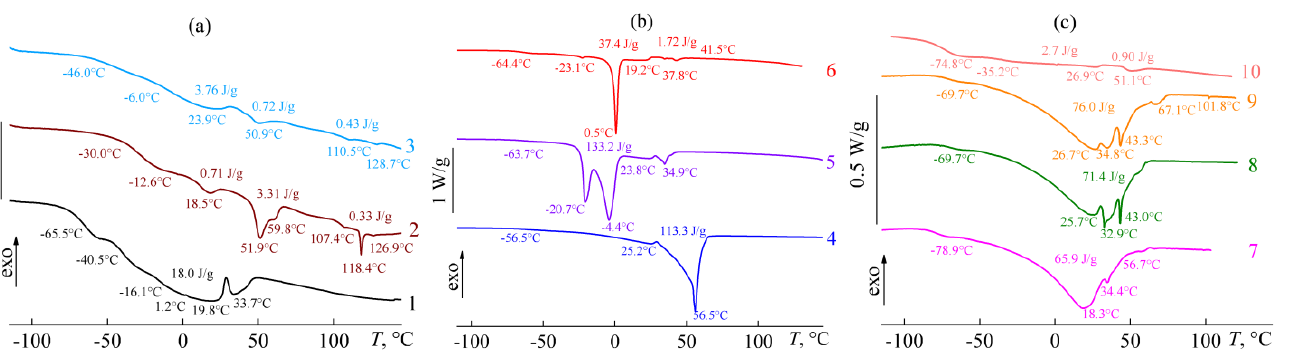
Figure 4. DSC thermograms of bitumens, whose numbers, transition temperatures, and transition enthalpies are shown near the curves. Transition temperatures were found by differentiating the curves.